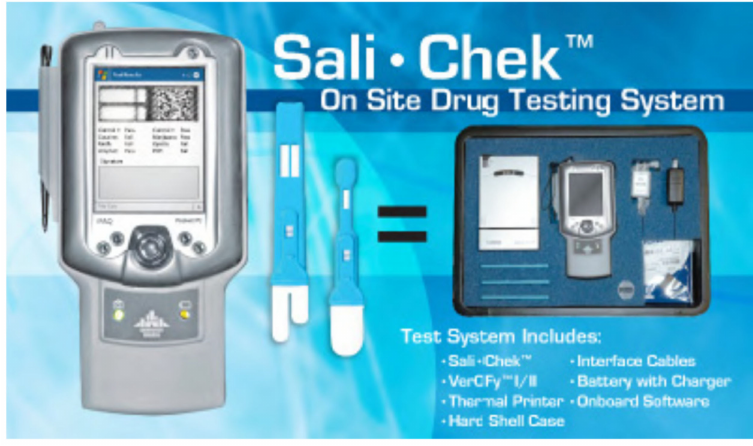
Figure 13. Sali Chek system [50].